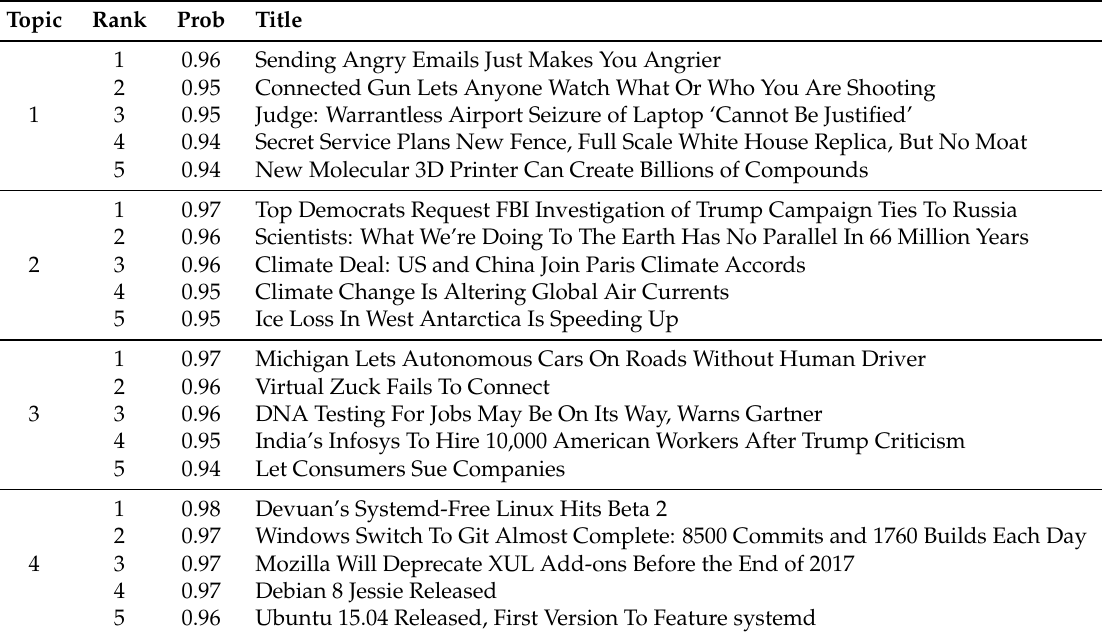
Table 5. Top-5 articles per topic in Slashdot data ( K = 4).